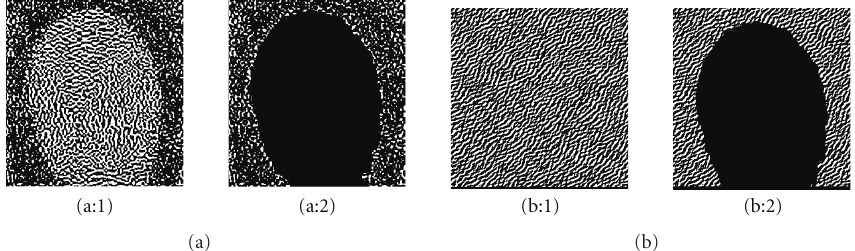
Figure 8: Standard watermarking of test image. Image 22 6: (a:1): di ff erence image between original and watermarked images in the DWT domain; (a:2): di ff erence image when removing ROI in the DWT domain; (b:1): di ff erence image between original and watermarked images in the DFT domain; (b:2): di ff erence image when removing ROI in the DFT